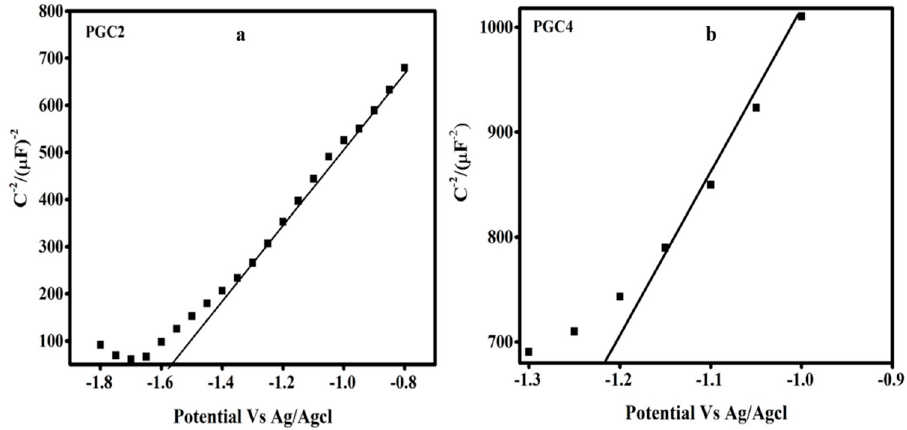
Figure 11. M ‐ S Plot for PGC2 ( a ) and PGC4 ( b ) composite. Figure 11. M-S Plot for PGC2 ( a ) and PGC4 ( b )